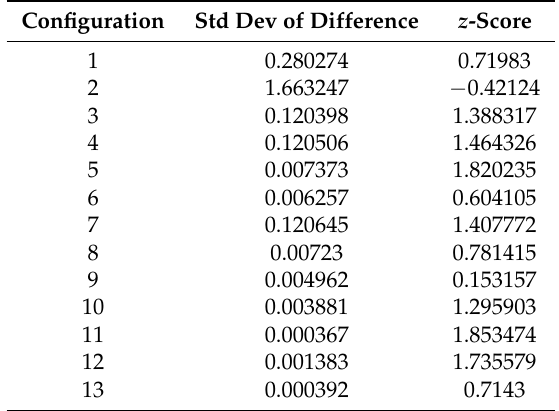
Table 5. Large-sample unpaired tests between the two means of best-of-run costs in Table 4.